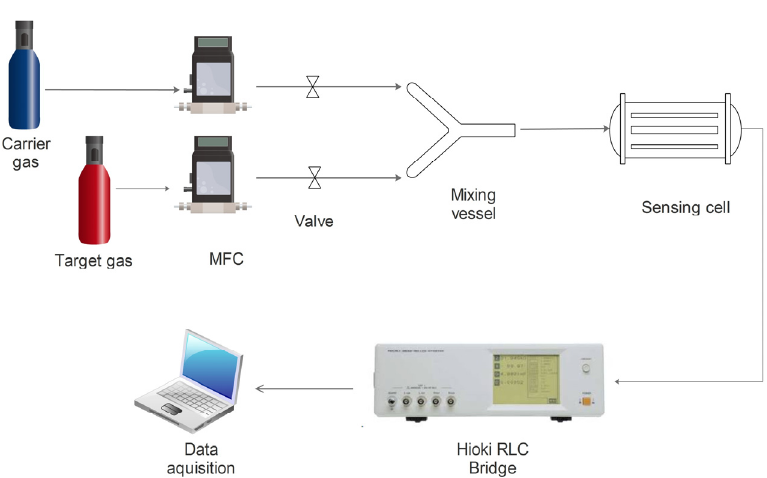
Figure 27. Schematic representation of the latest gas sensing experimental setup, from ref. [155].